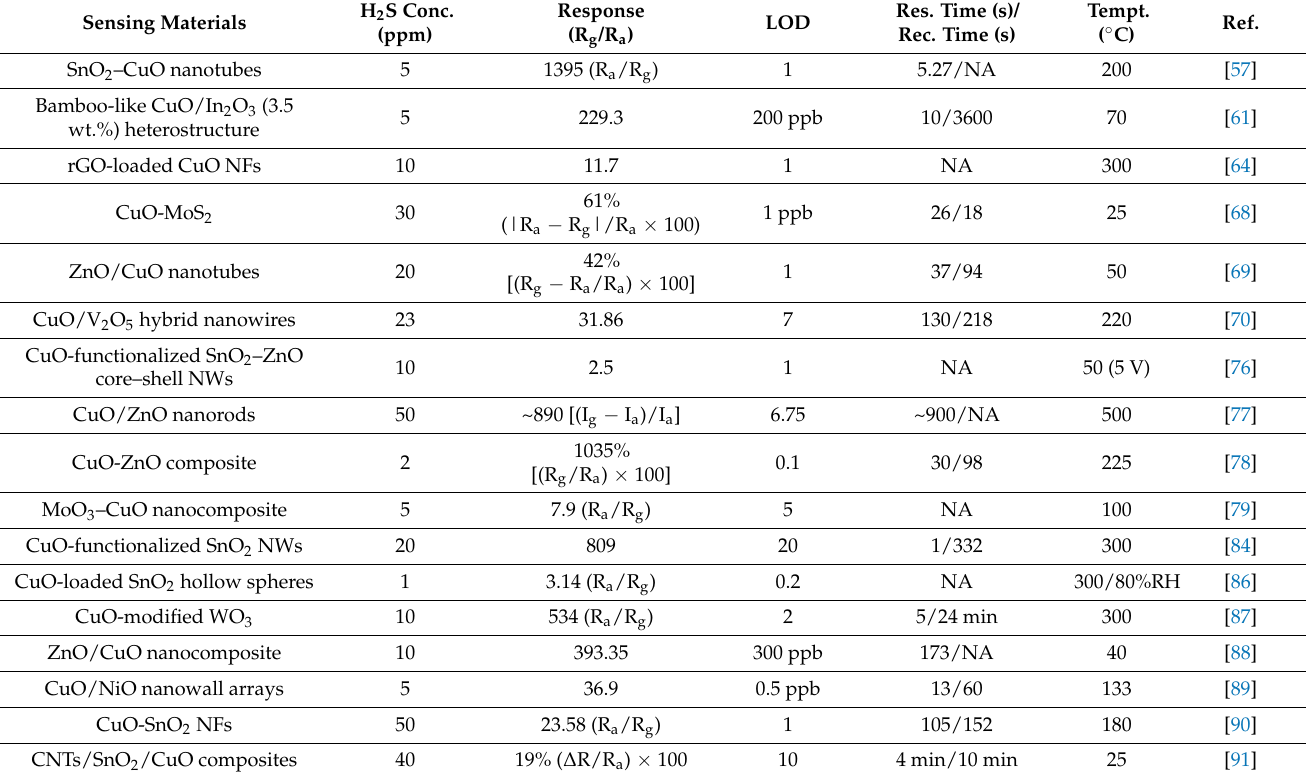
Table 4. H 2 S gas-sensing performances of CuO-based